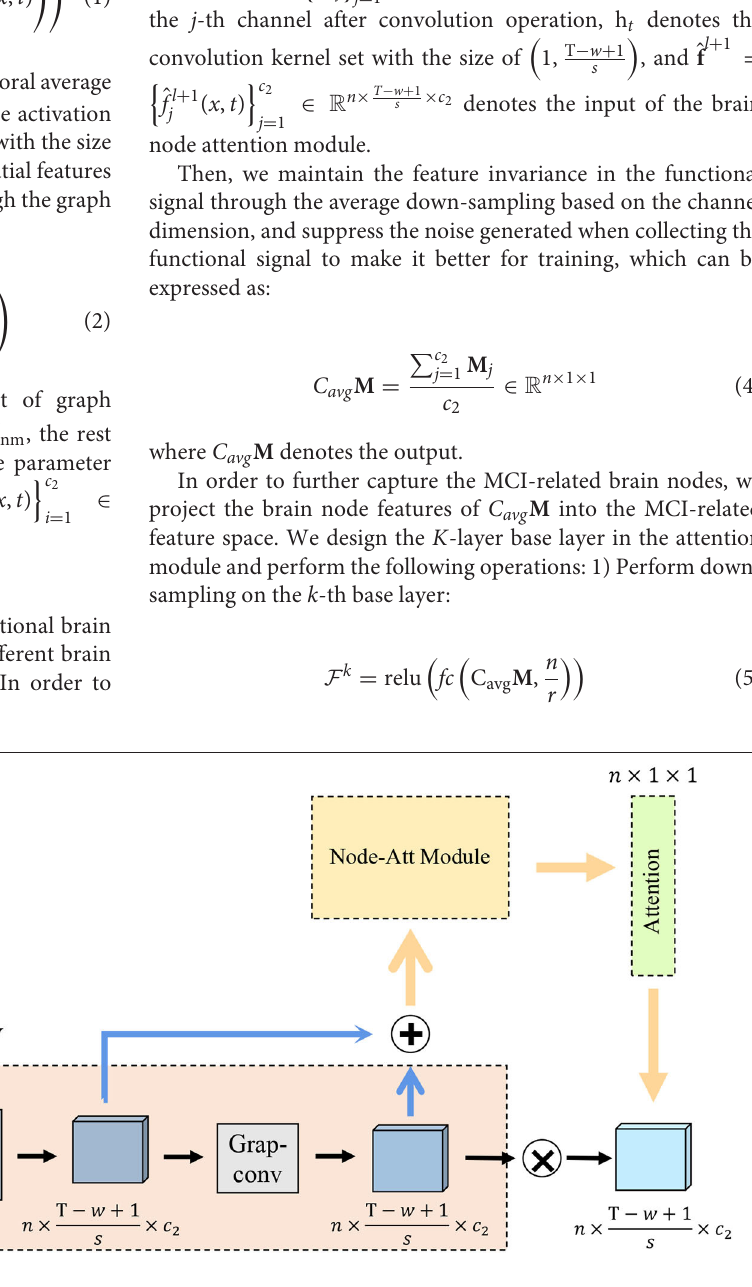
FIGURE 2 | Spatiotemporal convolution strategy structure illustration. Temporal-Conv represents temporal convolution operation, Temporal-AvgPool represents temporal average pooling, Grap-Conv represents graph convolution operation, Node-Att Module represents the brain node attention module, and Attention represents the brain node attention